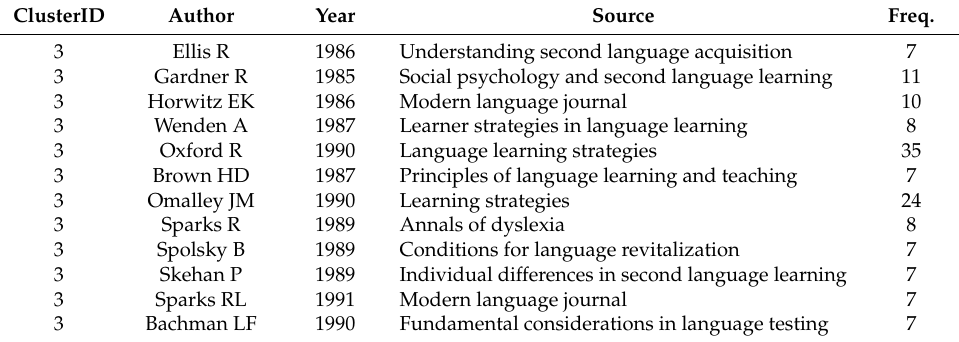
Table 5. The Members of Cluster #3.